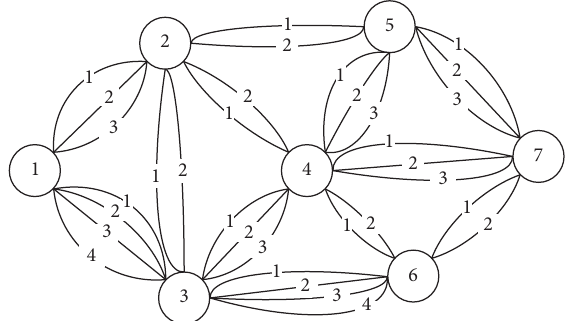
Figure 1: Multigraph of the